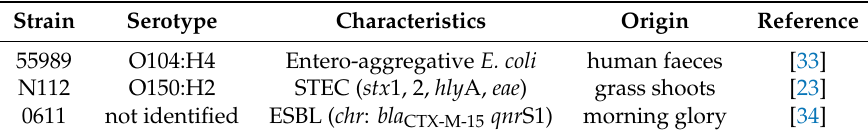
Table 1. E. coli strains used in this